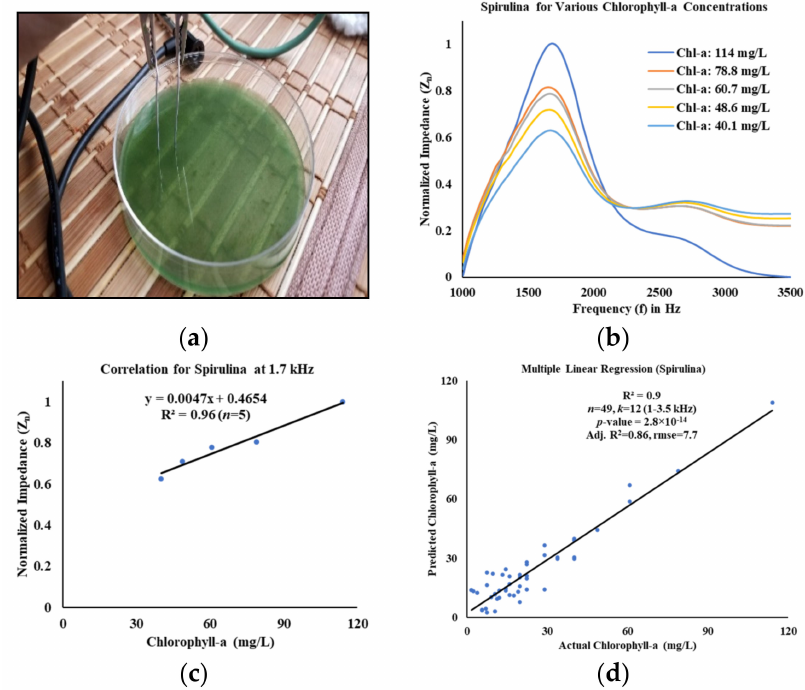
Figure 5. EIS measurements and performance analysis of Spirulina considering multiple regression: ( a ) measurement by the electrodes, ( b ) normalized impedance spectra, ( c ) correlation at 1.7 kHz, and ( d ) multiple regression at 1–3.5 kHz. Overall, a 95% correlation was found by the EIS measurements for 49 samples of Spirulina.